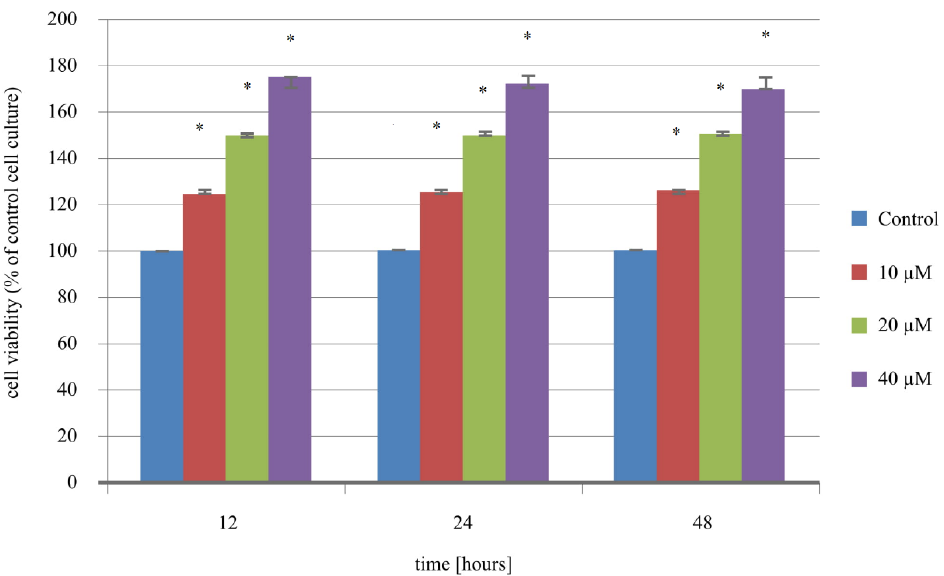
Figure 2. The results of increasing the concentration of leptin on endometrial cancer cell viability (*— statistically significant differences in comparison to the control cell culture; p < 0.05).